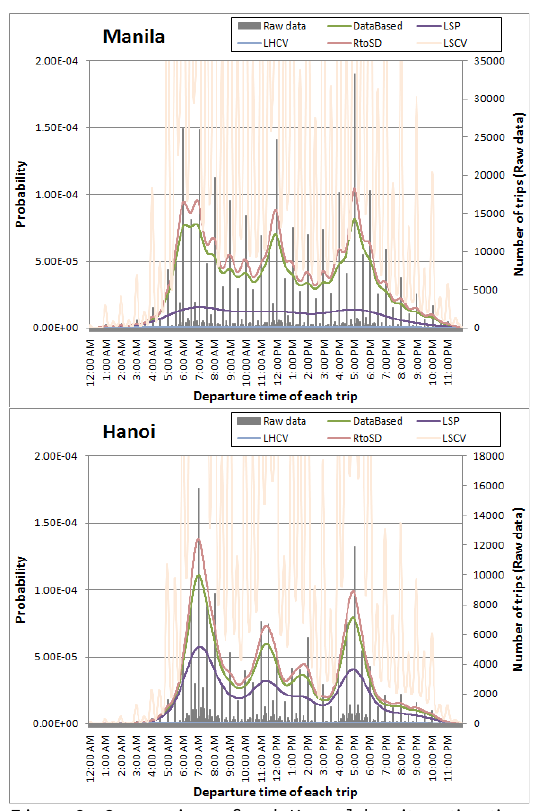
Figure 3. Comparison of each Kernel density